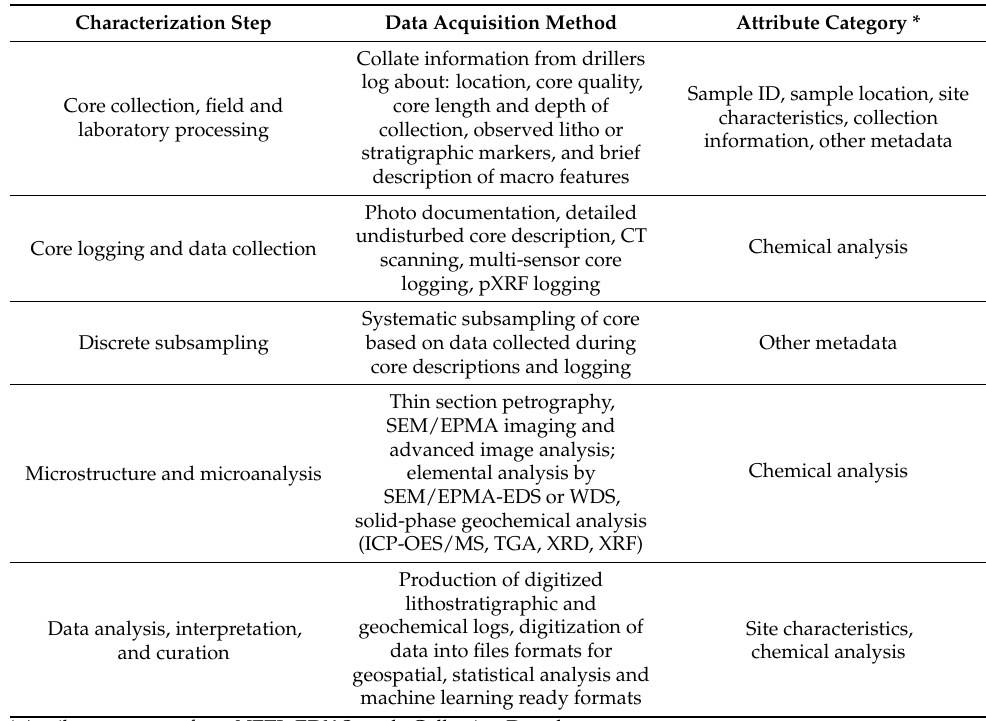
Table 1. Core characterization, data acquisition, and attribute categories for systematic collection and data analysis of geomaterials for studies on the occurrence of rare earth elements and critical minerals in sedimentary